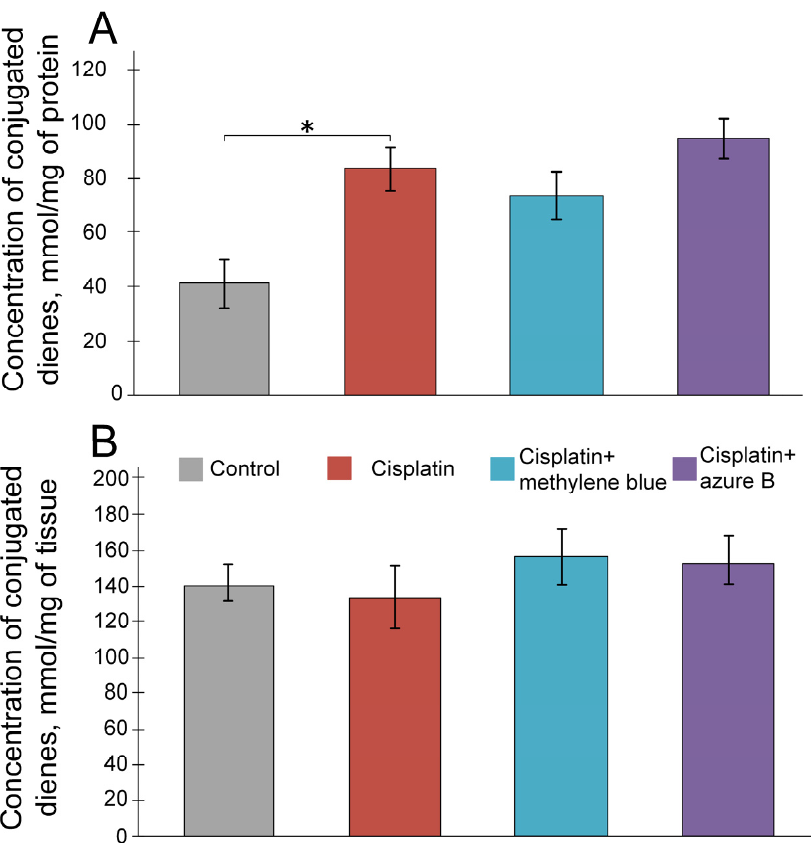
Figure 2. ( A ) Concentration of conjugated dienes in the in vitro experiment. Adding cisplatin to mitochondria increased the concentration of conjugated dienes. Subsequent additions of methylene blue or azure B had no effect on the concentration of the diene conjugates. The results are expressed as means ± SEM. All measurements were provided in at least four repetitions. ( B ) Concentration of conjugated dienes in the in vivo experiment. Cisplatin injection and methylene blue and azure B treatment did not impact on the concentration of conjugated dienes. * Differences are statistically significant p < 0.05 (Mann–Whitney test). Control ( n = 10), cisplatin ( n = 6), cisplatin + methylene blue ( n = 8), cisplatin + azure B ( n = 8).